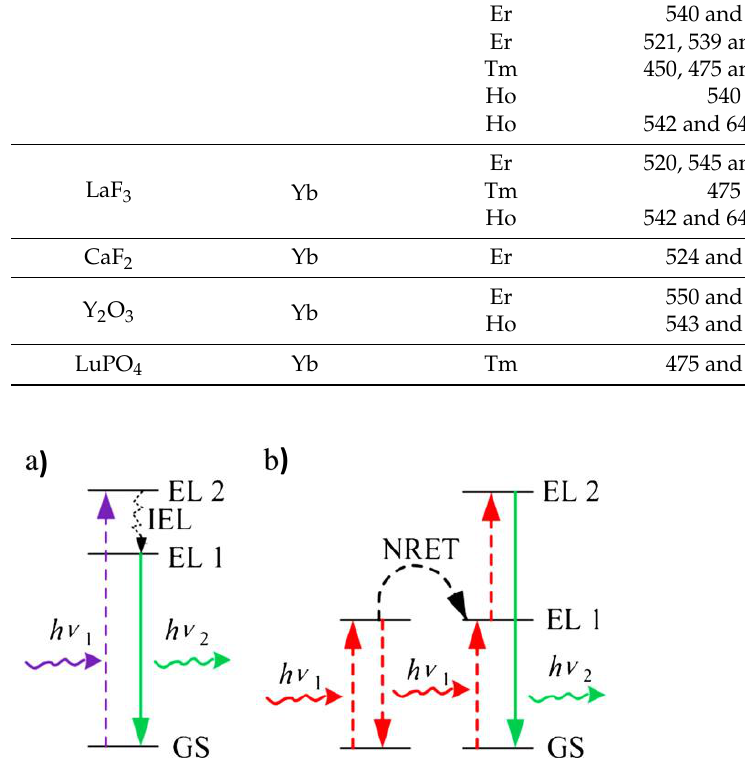
Figure 12. Illustration of ( a ) down-conversion and ( b ) energy transfer up-conversion mechanism. IEL: internal energy loss; GS: ground state; EL: energy level; NRET: non-radiative energy transfer; h 1 : incident light; h 2 : emission light. Reproduced from [17], with permission from ELSEVIER